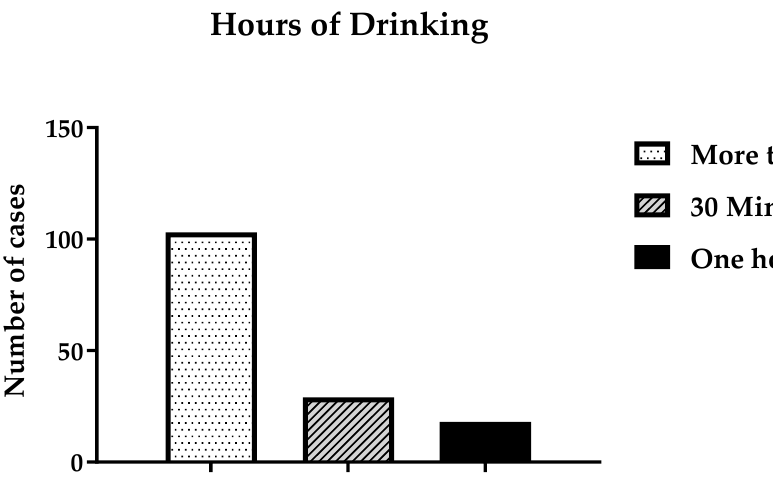
Figure 8. Time spent consuming alcohol.